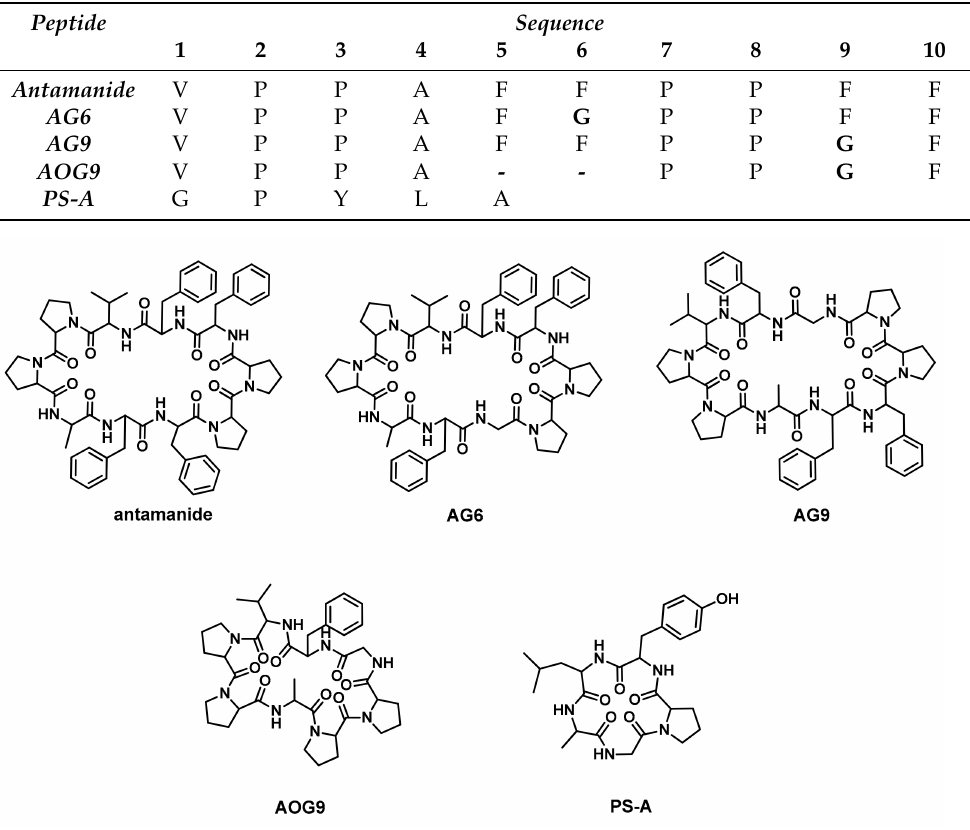
Table 1. Sequence of antamanide analogues and pseudostellarin A ( PS-A ) peptide.